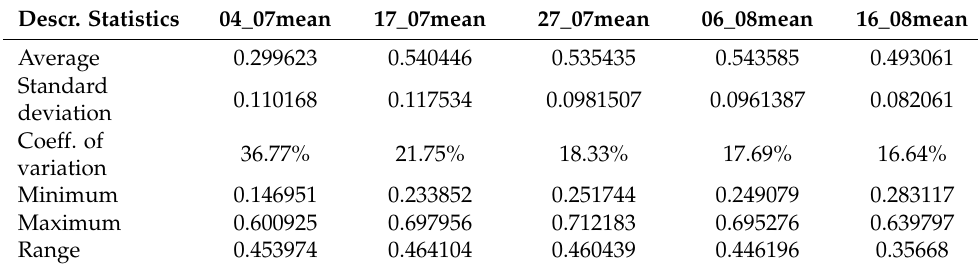
Table 2. The descriptive statistics of the NDVI mean values across all pilot fields during each data